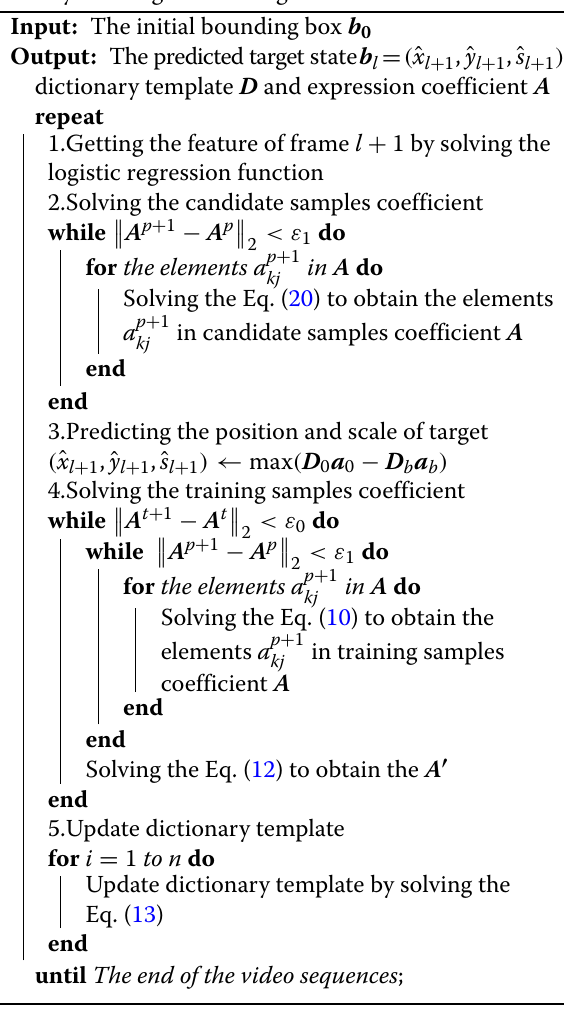
Algorithm 1: Online non-negative discriminative dic- tionary learning for